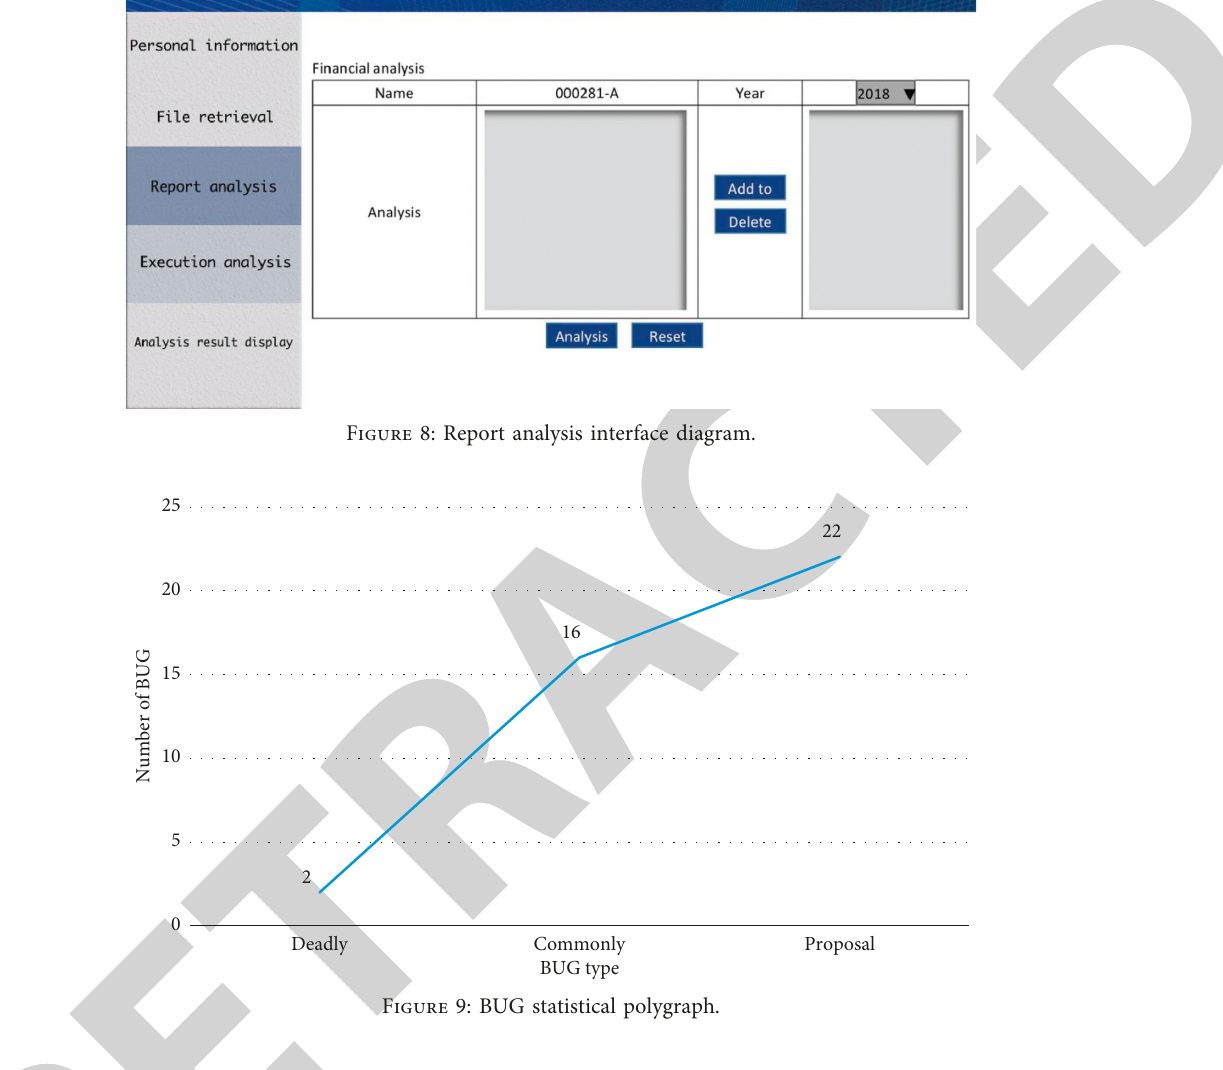
Figure 9: BUG statistical